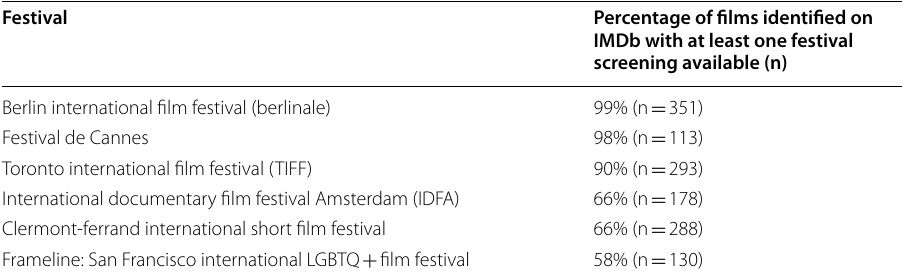
Table 2 Share of film data identified on IMDb by the sample festival Festival Percentage of films identified on